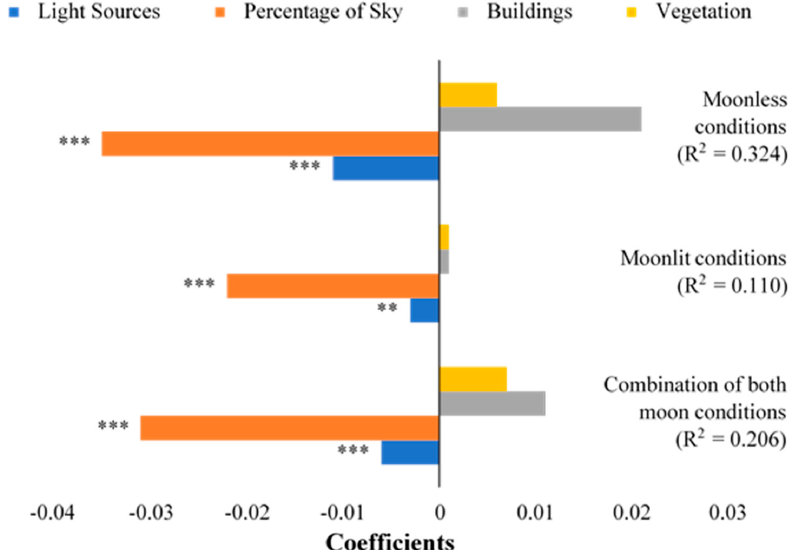
Figure 13. The coefficients for the variables determining brightness in the secondary backward stepwise multiple linear regression models for zenith photograph’s landward cone of acceptance (COA) sector. Significant variables are denoted with an asterisk (* = p < 0.05, ** = p < 0.01, *** = p < 0.001) and the adjusted R 2 for each model shown.